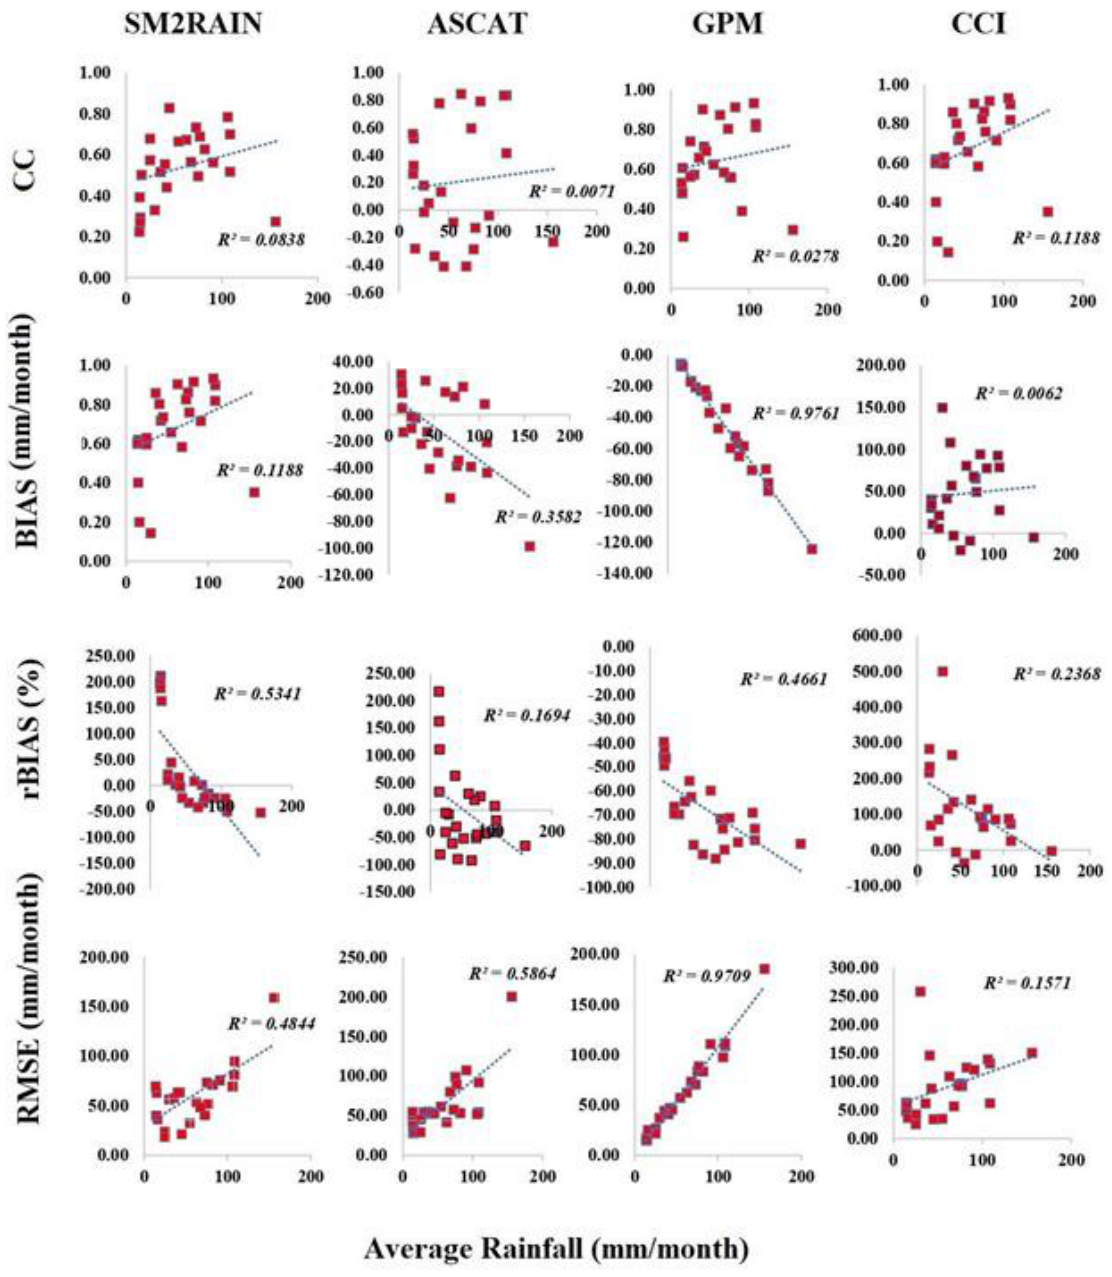
Figure 5. Impact of aerial average precipitation on evaluation indices of all SPPs.